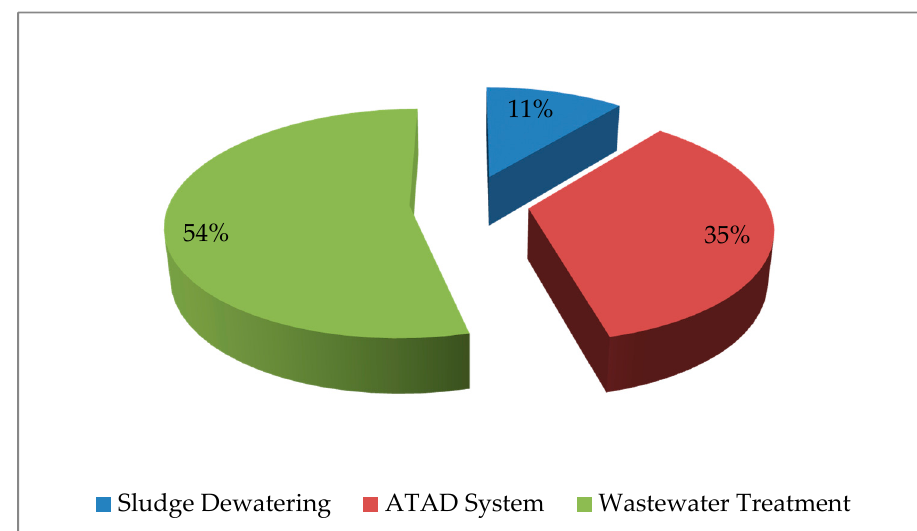
Figure 5. Participation of technological processes in total annual electricity consumption [24].